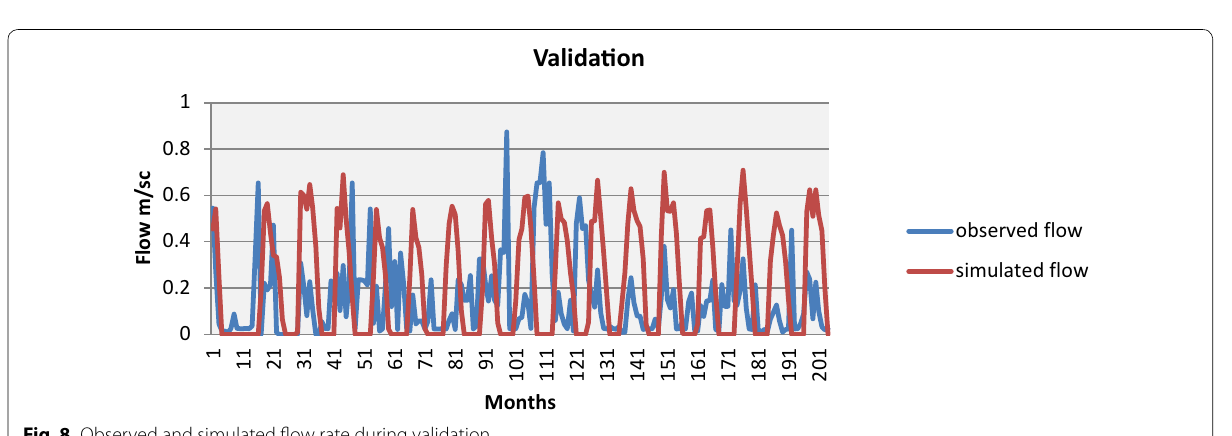
Fig. 8 Observed and simulated flow rate during validation